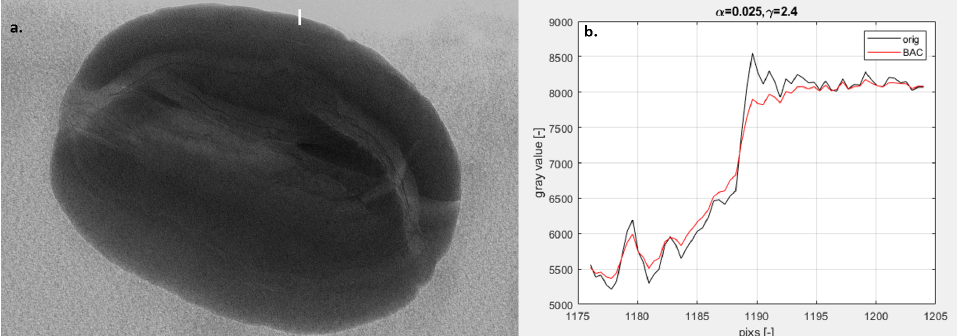
Figure 2. ( a ) Propagation based projection image of a coffee bean ( b ) Illustrates the result of the optimization of the α and γ parameters of the BAC method showing a comparison of the original and BAC corrected image gray scale profiles over the white vertical line shown in ( a ). Note that foamy looking material around the bean is florist’s foam in which the bean was embedded for the scan.